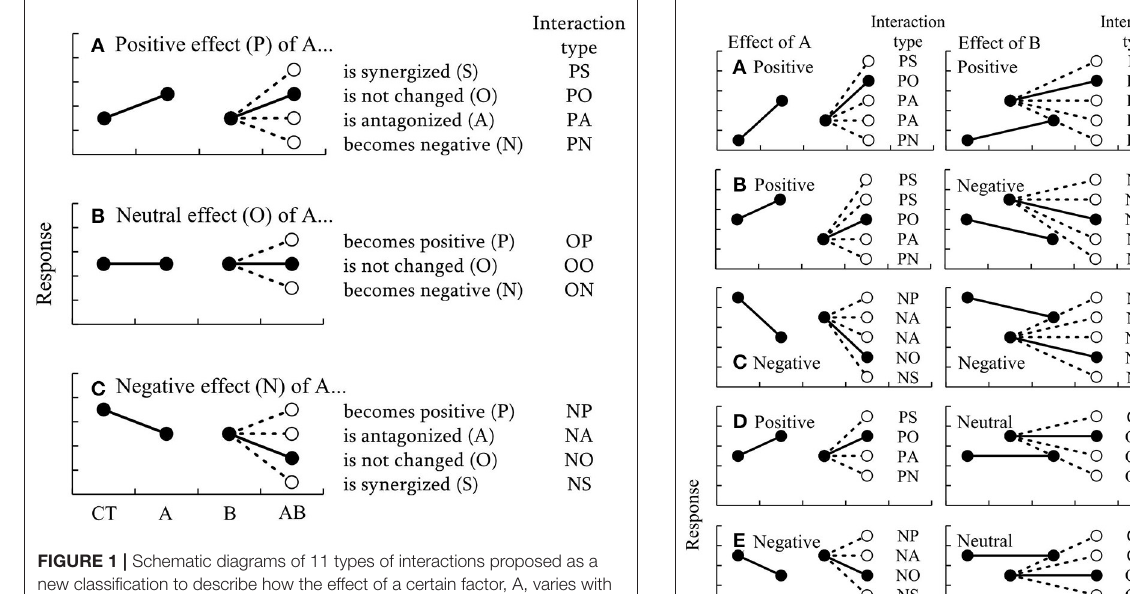
be antagonized (PA) or reversed by A (PN), resulting PA-PA or PA-PN, respectively.